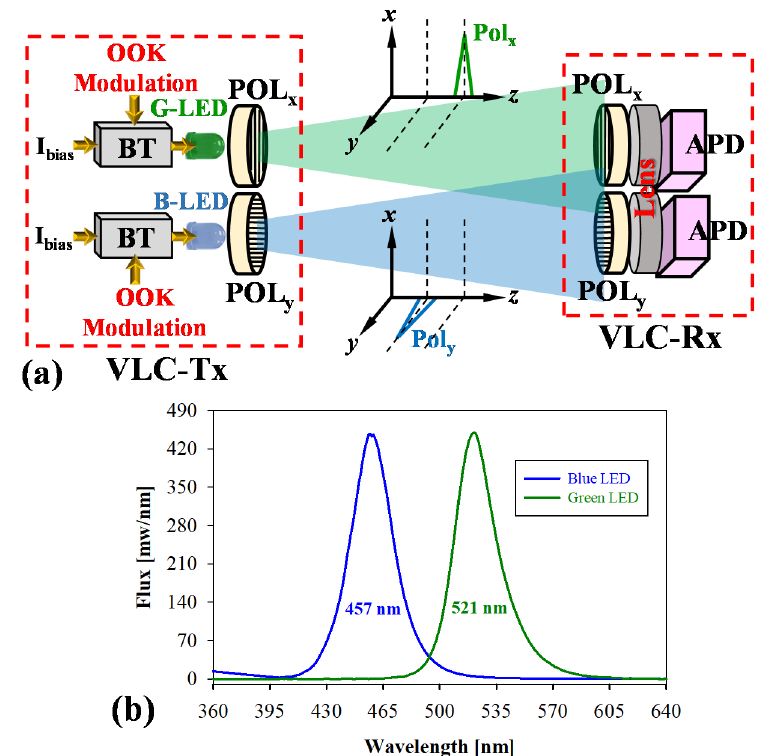
Figure 1. ( a ) Proposed dual-polarized G- and B-LED VLC transmission system. ( b ) Observed output spectra of G- and B-LEDs, when the bias currents are both operated at 10